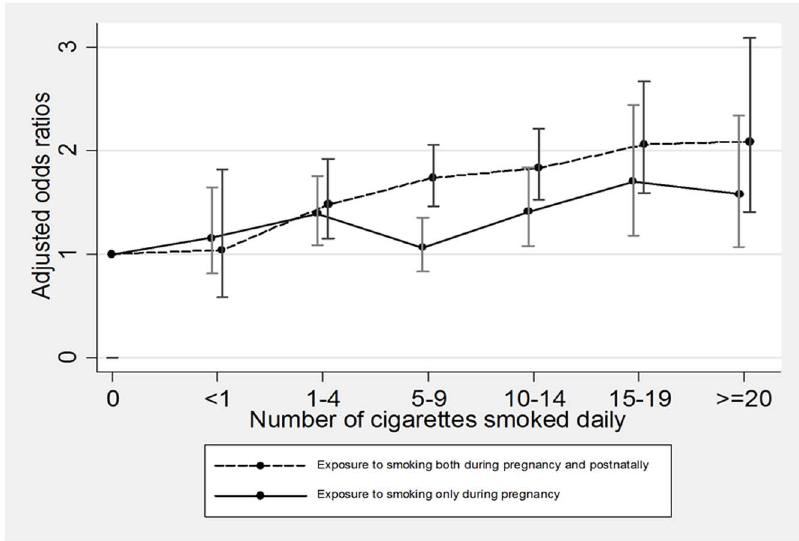
Figure 4. The figure shows the odds ratios of overweight at age 7 years with increasing numbers of cigarettes smoked daily during pregnancy by two different exposure periods, either exposure only during pregnancy, or exposure both during pregnancy and postnatally. The odds ratios were adjusted for child sex, parity, birth weight, gestational age at birth, maternal age at birth, maternal gestational weight gain, maternal pre-pregnancy BMI, paternal smoking and socio-occupational status.